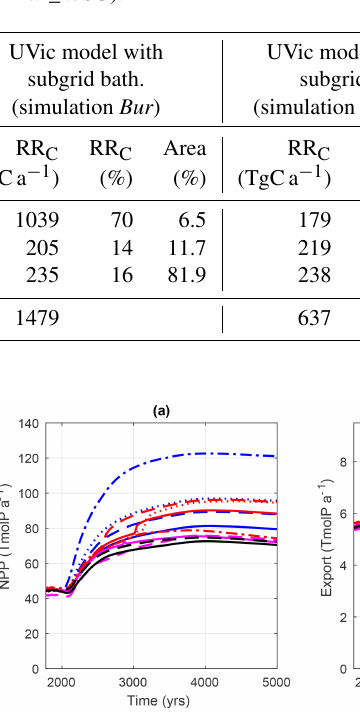
Figure 6. Globally integrated (a) ocean net primary production (NPP) in TmolPa − 1 and (b) export of organic P below the 130m depth level in TmolPa − 1 . Simulation descriptions can be found